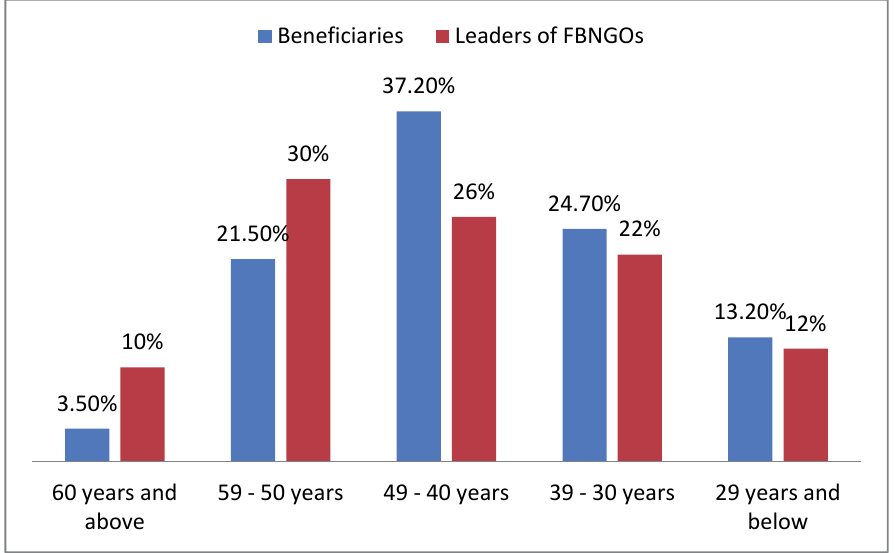
Figure 3: Histogram showing the age of the NGOs beneficiaries and their